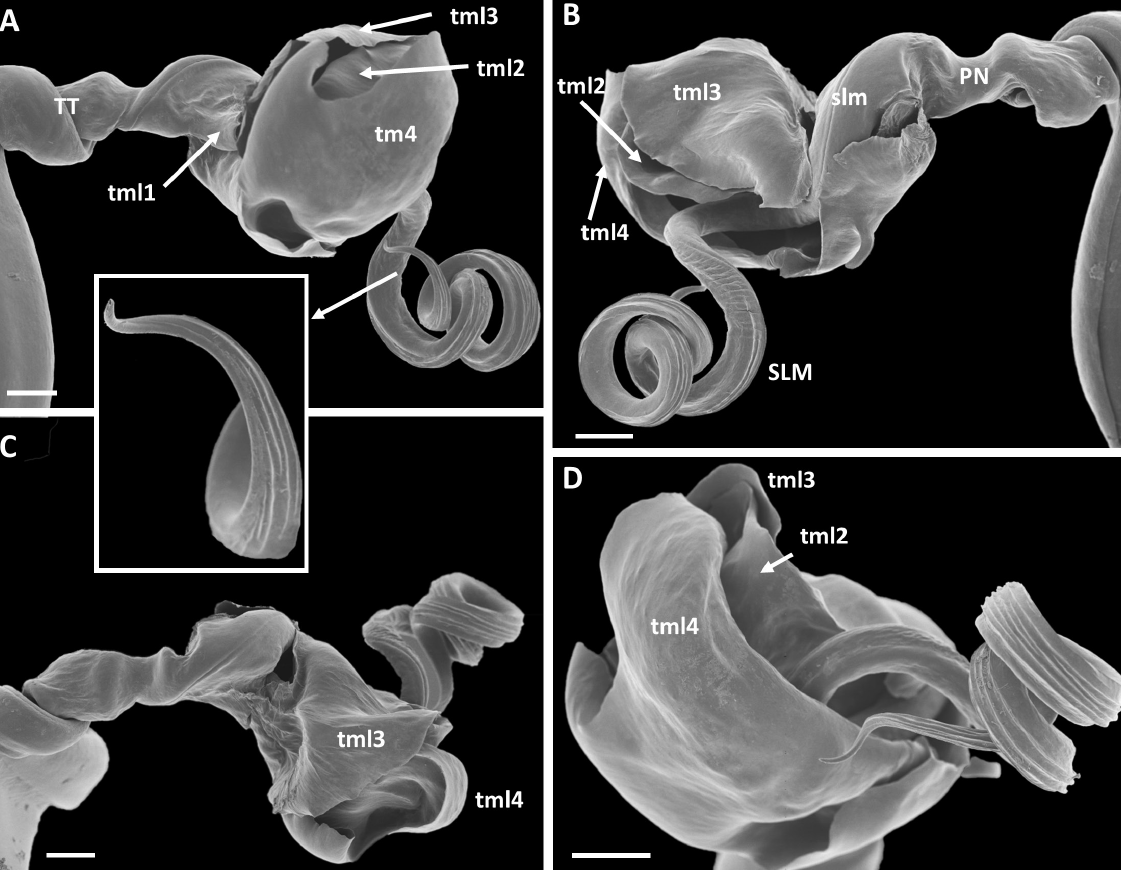
Fig. 36. Chaleponcus soerensenae sp. nov., holotype, ♂ (NHMD 621735), left gonopod telopodite. A . Anterior view, inset: close-up of solenomere tip. B . Posterior view. C . Ventral view. D . Mesal view. Abbreviations: PN = post-torsal narrowing; SLM = solenomere; tml1-4 = telomeral lobes; TT = torsotope. Scale bars = 0.1